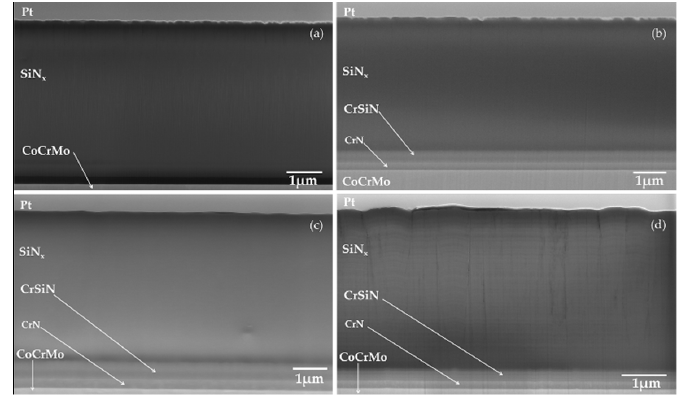
Figure 2. Cross-sections of ( a ) CoCr-SiN x , without CrN interlayer, a dense coating could be observed; ( b ) CoCr-CrN(H)-SiN x , deposited using 1-fold rotation and a negative bias voltage of 900 V; ( c ) CoCr-CrN(L)-SiN x , with 1-fold rotation and a negative bias of 100 V; and ( d ) CoCr-CrN(L)-SiN x -3f, deposited using 3-fold rotation and a negative bias of 100 V.